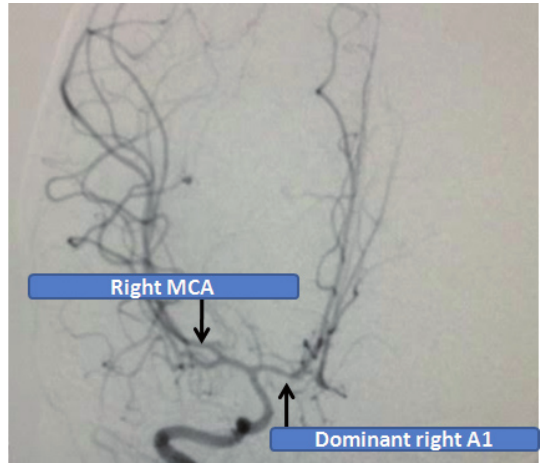
Figure 4. Angiography revealing both A2’s supplied by the right A1.